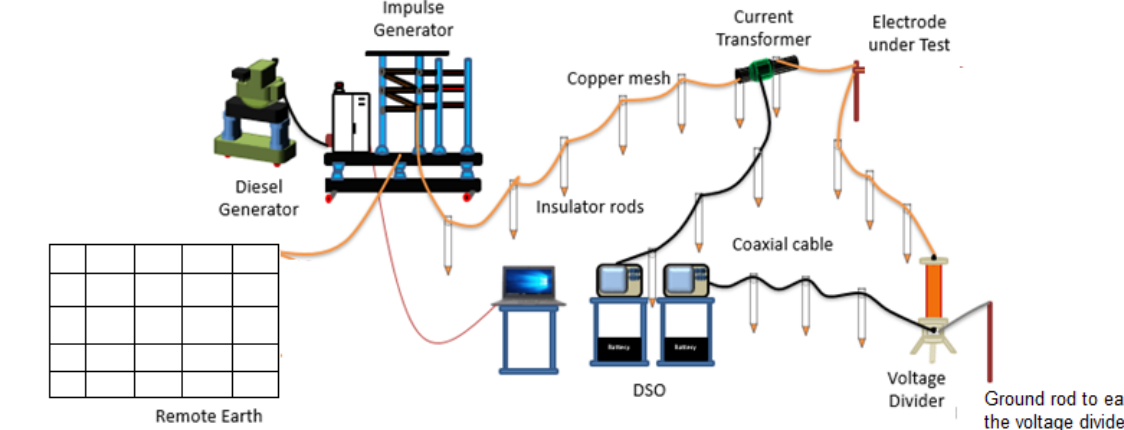
Figure 6. Impulse test arrangement .